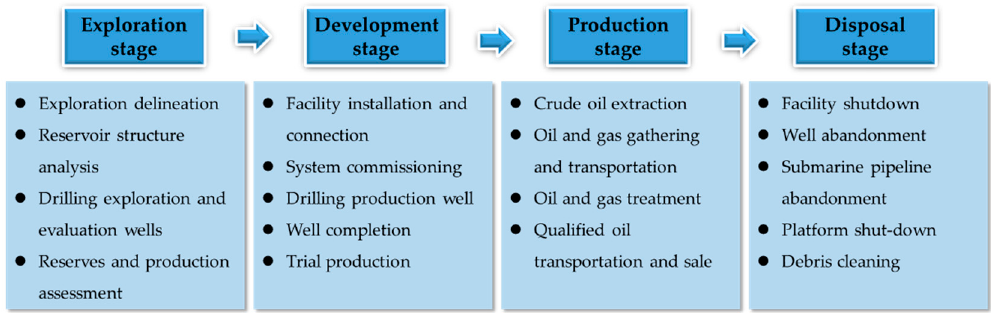
Figure 1. Offshore oil project procedure.